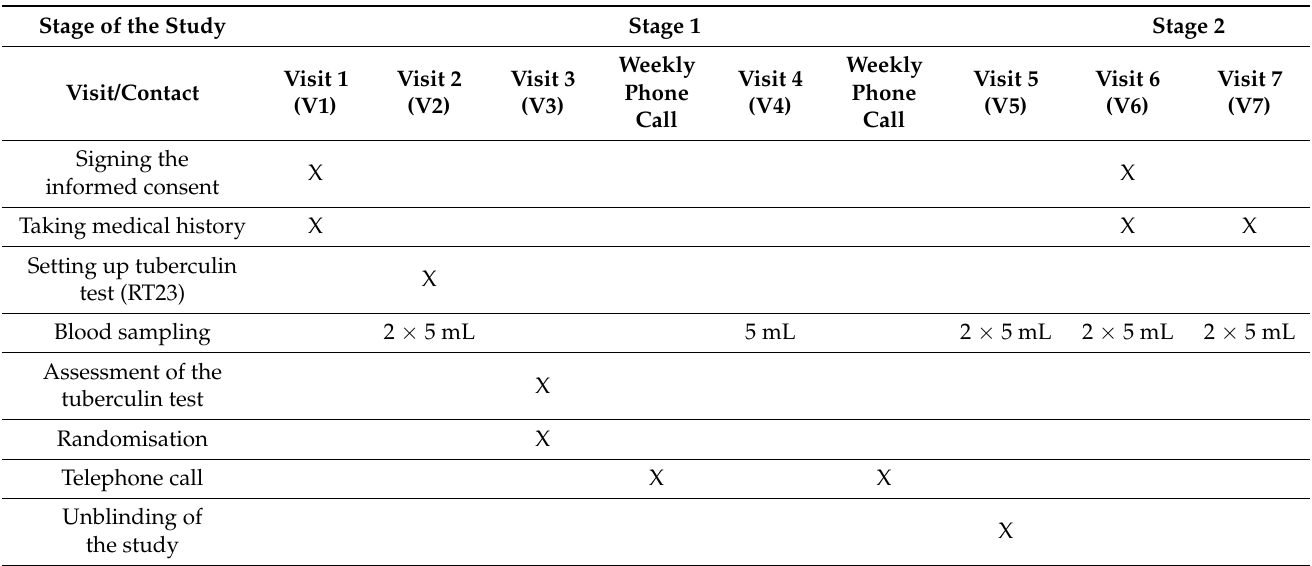
Table 2. The study plan. Patients who did not complete V5 had an antibody level assay performed from V4. Some patients had combined V4 and V5 visits due to the population vaccinations against COVID-19 introduced and the need to accelerate